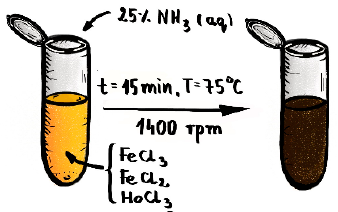
Figure 1. Reaction set for synthesis of Ho doped SPIONs.